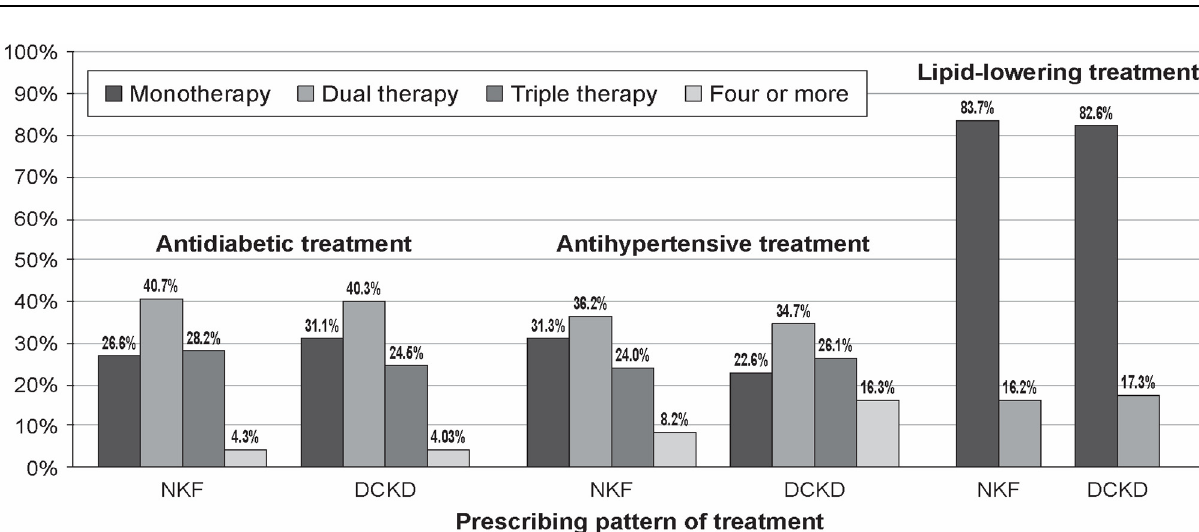
Figure 1. Prescribing pattern of treatment (NKF: normal kidney function, DCKD: diabetic chronic kidney disease).